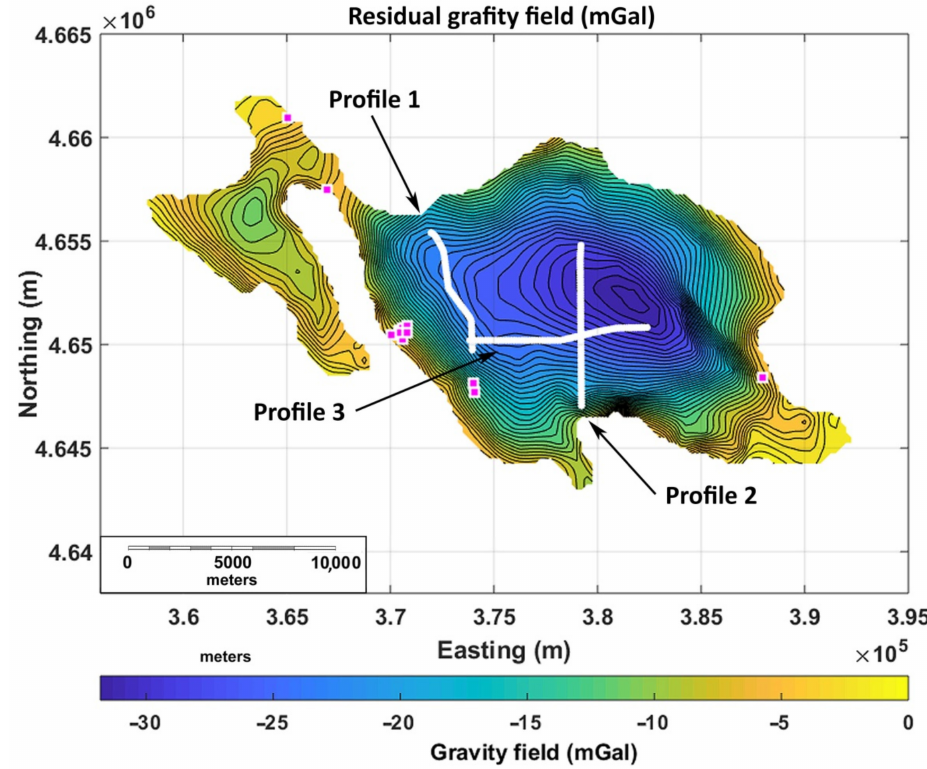
Figure 2. Residual gravity field of the Fucino plain used for modelling the basement depth. White points and magenta squares indicate the position of seismic and borehole data, respectively, used as constraints to the basement depth in the gravity modelling. Contour interval: 0.75